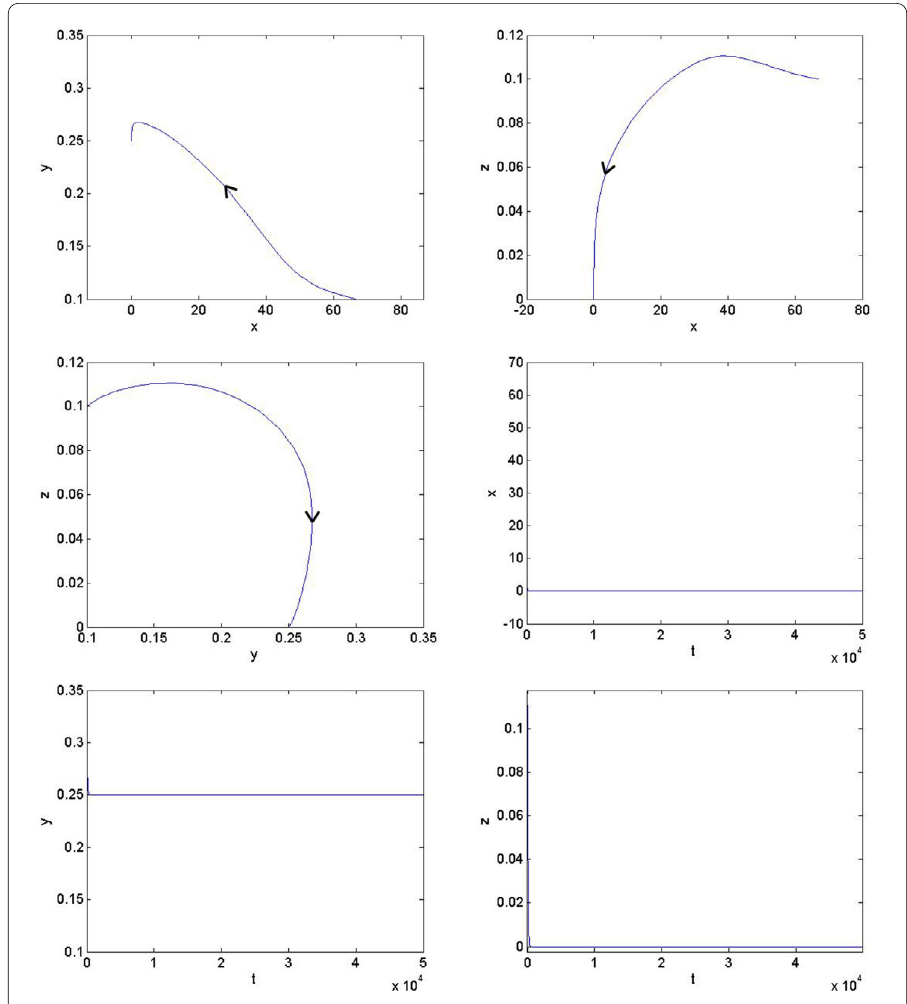
Figure 10 A computer simulation of the system of Eqs. (4)–(6) with c 1 = 0.2 day –1 , c 2 = 0.95 day –1 , c 3 = 0.239 day –1 , c 4 = 0.6 day –1 , c 5 = 0.01 day –1 , k 1 = 67.0, k 2 = 0.51, k 3 = 0.02, h 1 = 0.024, h 2 = 0.063, e 1 = 0.001 day –1 , e 2 = 0.8 day –1 , e 3 = 0.9 day –1 , γ 1 = 0.01 day –1 , γ 2 = 0.1 day –1 , (cid:8) = 0.05 and δ = 0.9 where x (0) = 67, y (0) = 0.1 and z (0) = 0.1, for which all conditions in Theorem 5 are satisfied. The solution trajectory tends towards a stable equilibrium point as theoretically predicted